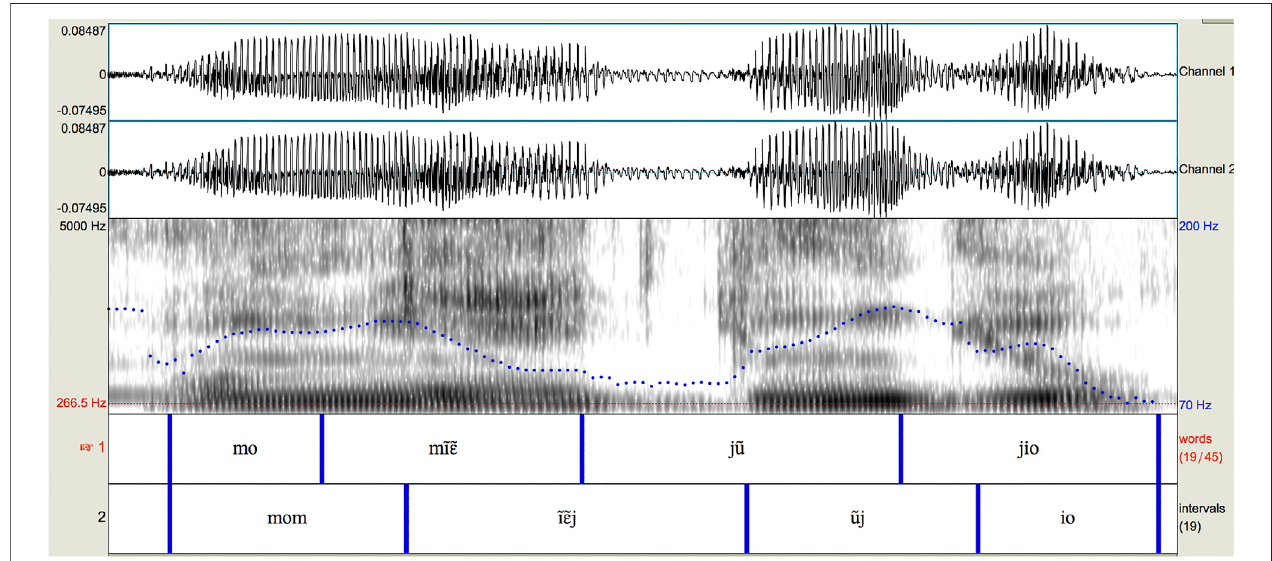
FIGURE 5 | Syllable (top tier) and interval (bottom tier) timing of spoken phrase mo ́ mi ̰̂ ε ̰ ju ̰̌ ji ̂ o “ I saw a long snake ” .